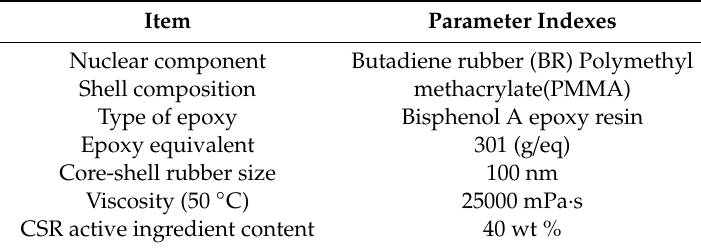
Table 1. The major parameters of CSR